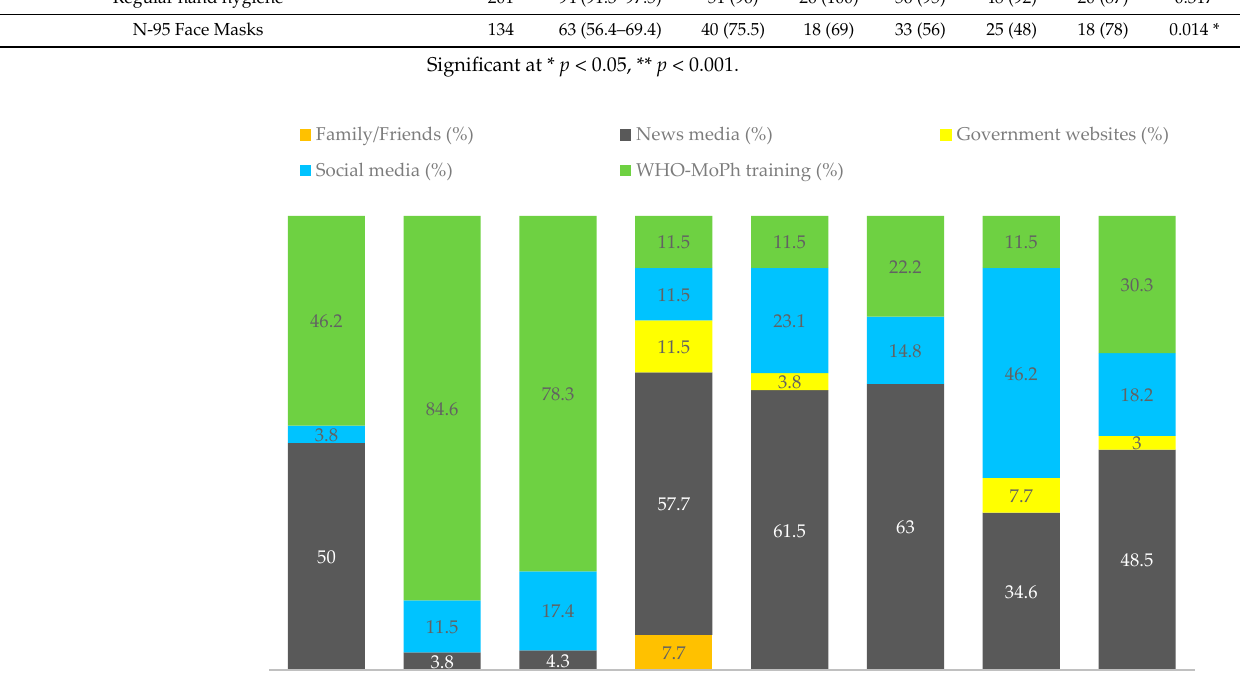
Figure 1: Cumulative incidence of COVID-19 in the surveyed regions-Afghanistan, as of May